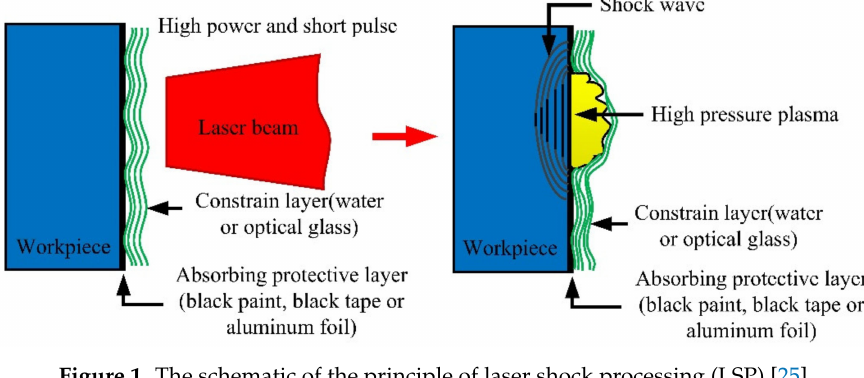
Figure 1. The schematic of the principle of laser shock processing (LSP) [25].